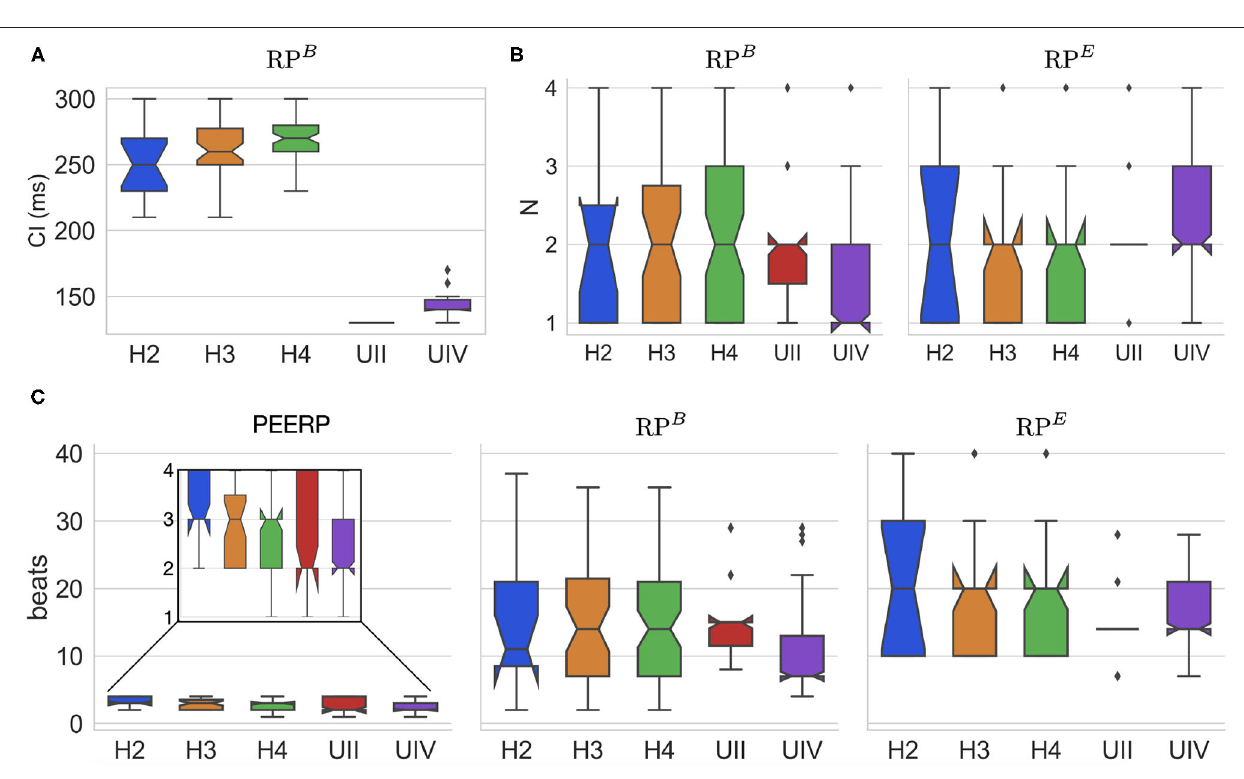
considered increasing inter-point distances of 1.5, 2, 2.5, and 3 cm. The sensitivity analysis results are presented in Table 1